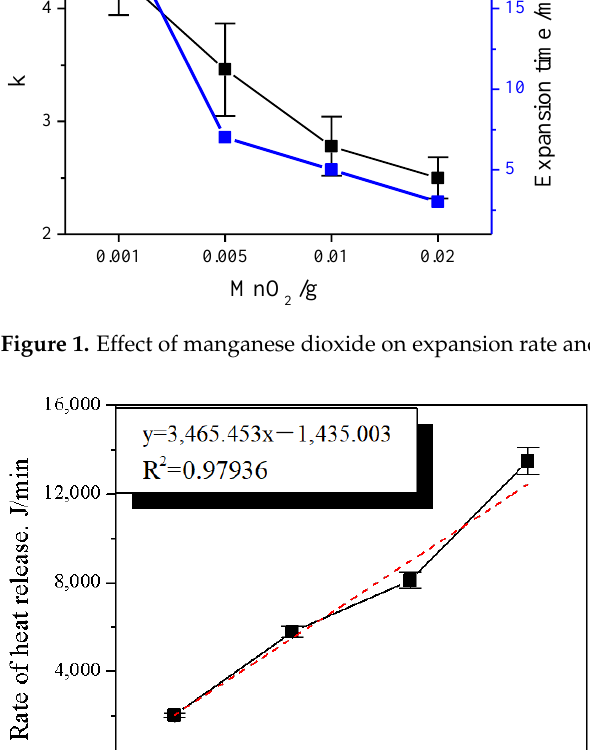
Figure 4. Effect of manganese dioxide on the structure of functional groups. To visualize the effect of manganese dioxide on the expansion, SEM tests were per- formed, as shown in Figure 5. Figure 5b – e shows the microstructure of the samples with different manganese dioxide. At 0.001 g, the Vrm layer was the thinnest and the average layer spacing was the largest. With the increase in MnO 2 , the interlayer spacing of Vrm gradually decreased. The thickness of the layer also increased. The Vrm layers were not exfoliated at 0.02 because too fast an exothermic rate cannot reach expansion. It is con- sistent with the results in Figure 1. That is, the expansion rate was the largest at 0.001 g of MnO 2 . It is calculated that the exothermic rate at this time was 1960.42 ～ 2089.164 J/min. At this rate, the expansion effect is the best. It can effectively increase the volume of Vrm